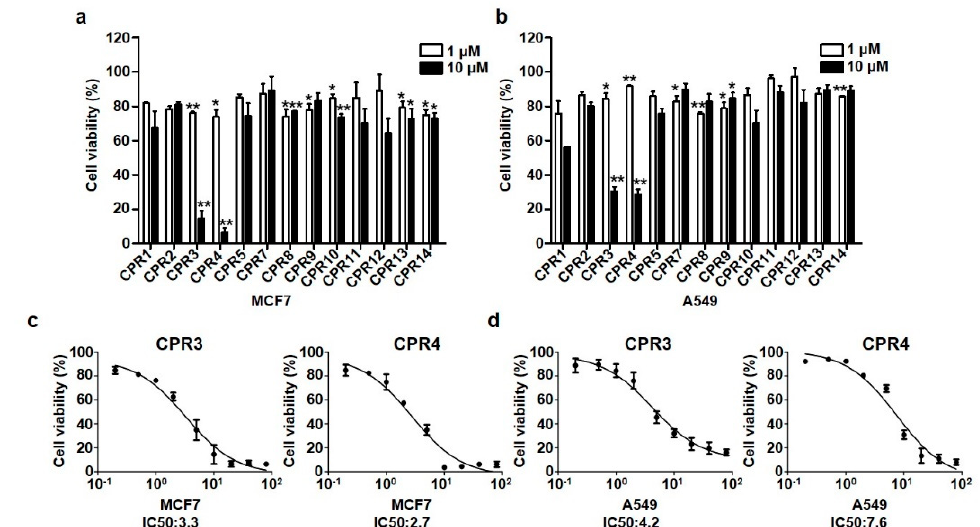
Figure 2. Inhibitory effect of PROTAC compounds on the viability of two different cancer cell lines, MCF7 ( a ) and A549 ( b ). PROTAC compounds were treated at 1 or 10 µ M of concentration for 3 days in a complete RPMI-1640 medium. At various concentrations of CPR3 ( c ) or CPR4 ( d ), the IC 50 value was calculated through the growth curve in both cell lines. Cell viability was determined by the changes in absorbance at 570 nm. * P ≤ 0.05 and ** P ≤ 0.01, as determined by Student’s t-test.